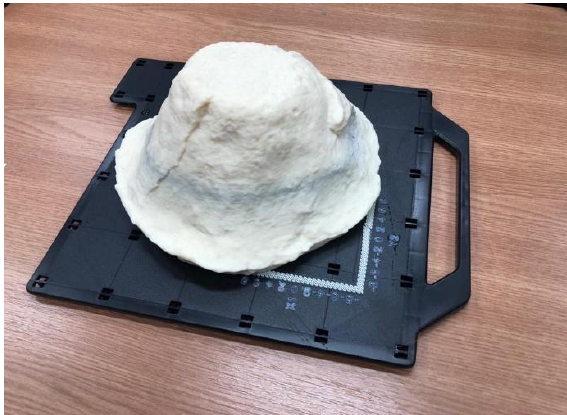
Figure 14. Rapid prototyping (3D printing) was used for the creation of the final model (the bowl from Qala Shila), 3D printer Stratasys F 120